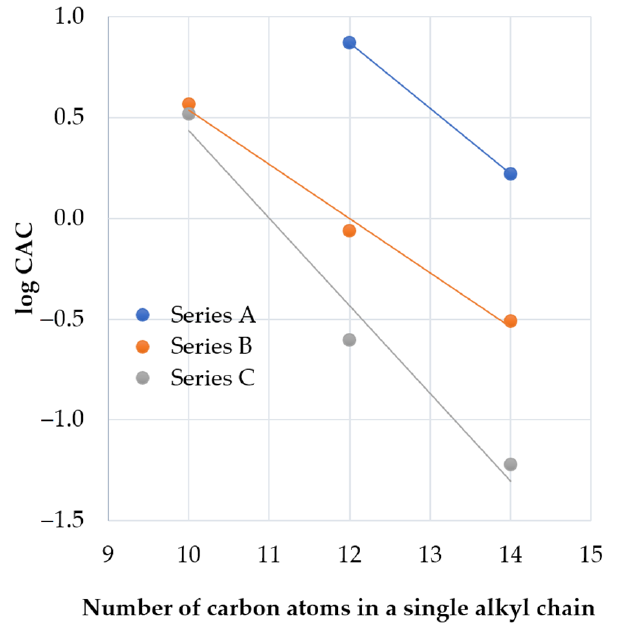
Figure 4. LogCAC vs. carbon atoms in a single hydrophobic chain for each series of the lipopeptides.